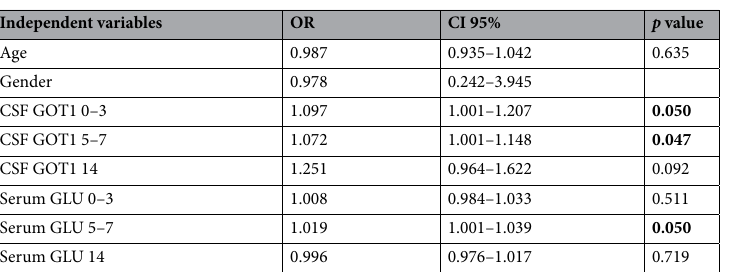
Table 2. Odds ratio (OR) of increased intracranial pressure (ICP) in 45 SAH patients during their hospitalization. Age, gender, and CSF GOT1 levels and serum glutamate as predictors. OR, odds ratio; CI, confidence interval; CSF, cerebrospinal fluid, GOT1, glutamate–oxaloacetate transaminase. Significant values are in [bold].